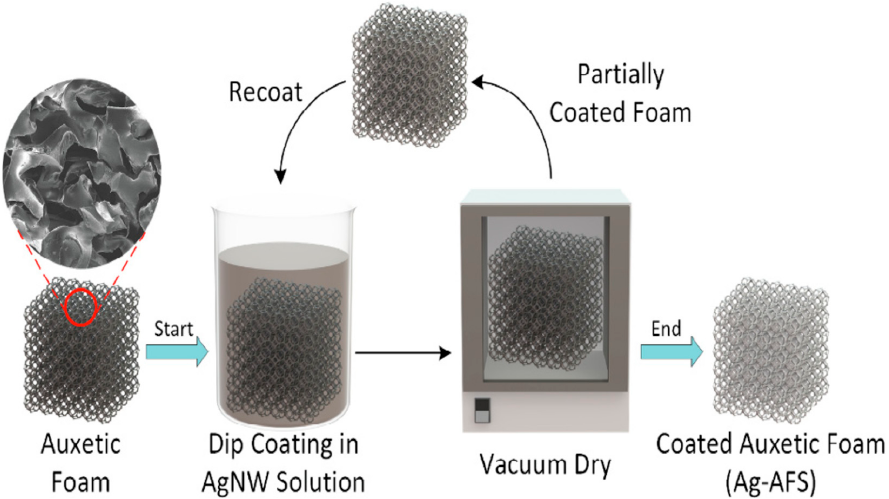
Figure 11. Schematic of the AgNW foam sensor fabrication process. Reprinted with permission from Ref. [101]. Copyright 2019, Elsevier.